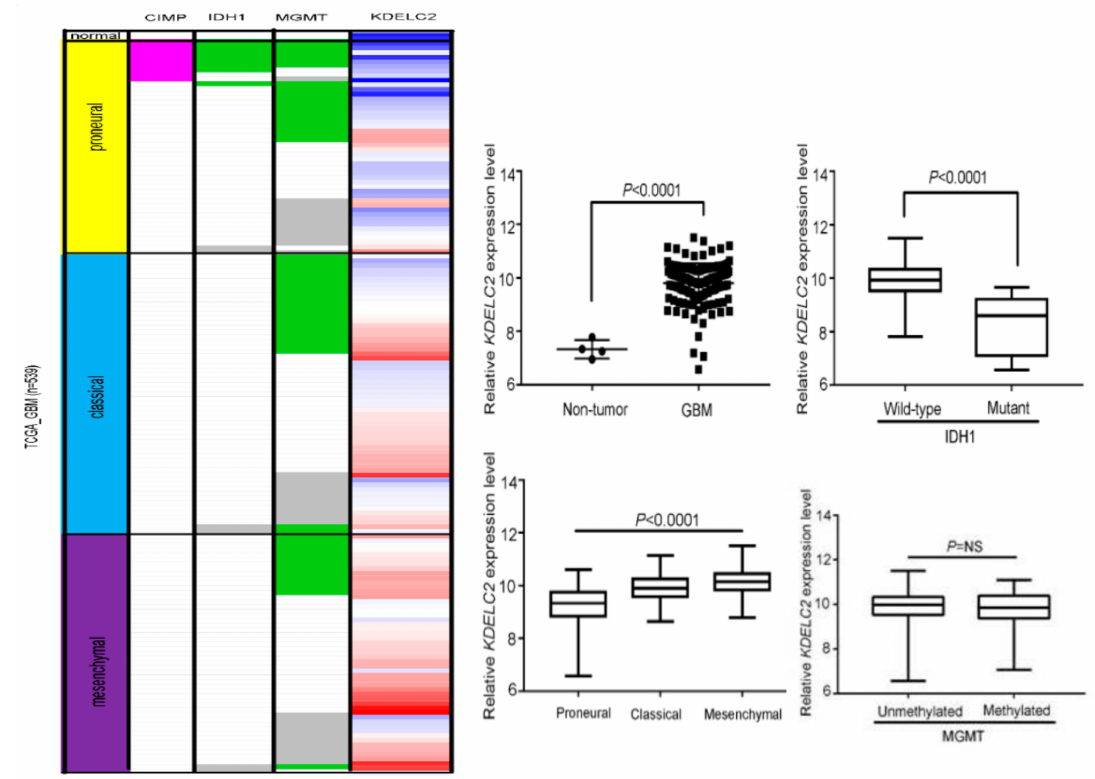
Figure 1. Expression analysis of KDELC2-induced tumorigenesis in glioblastomas (GBMs) in The Cancer Genome Atlas database. KDELC2 mRNA overexpression correlated with mutant IDH1, mesenchymal subtype, G-CIMP, but was not related to MGMT methylation of GBMs. Bars, means ± SEM. * p < 0.05; ** p < 0.01; *** p < 0.0001; p = NS,